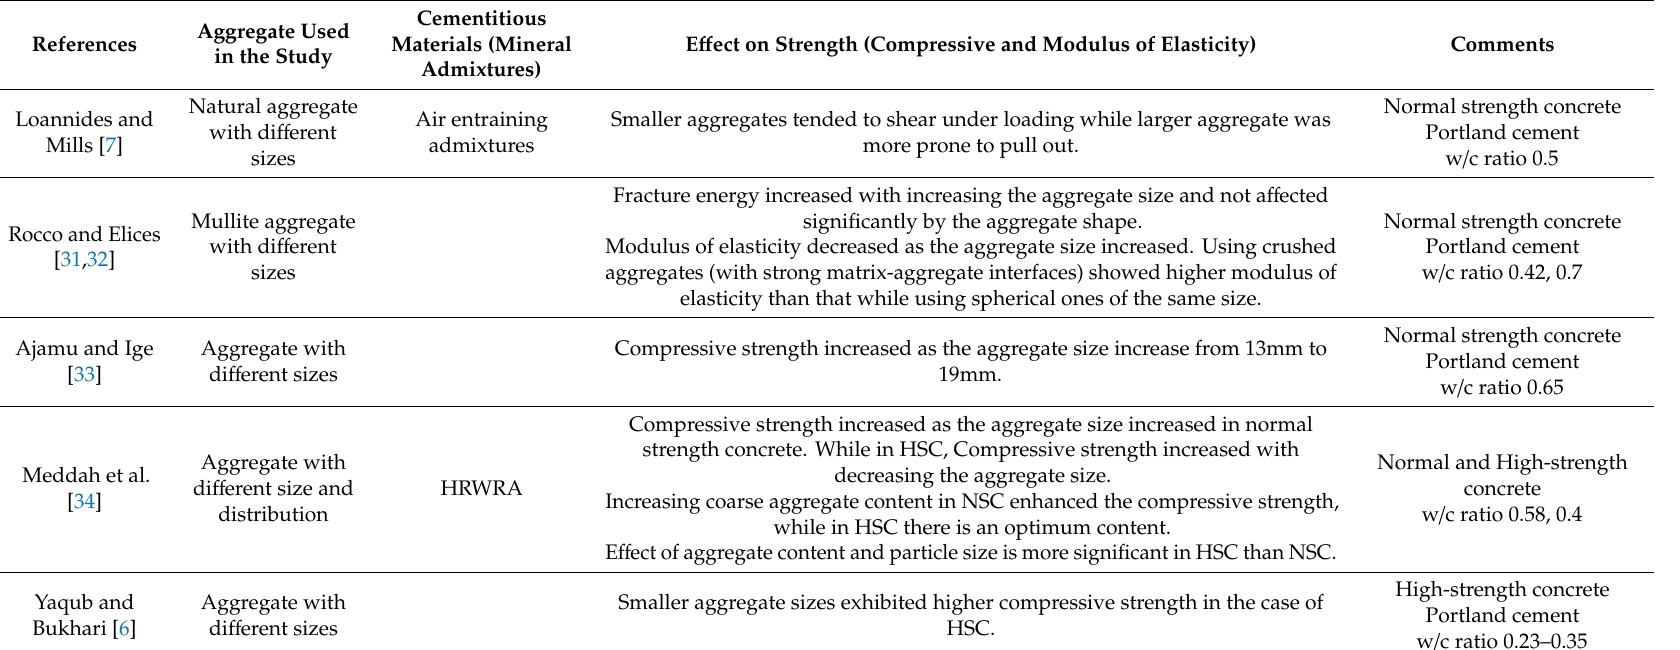
Table 3. The e ff ect of aggregate size and shape on concrete compressive strength